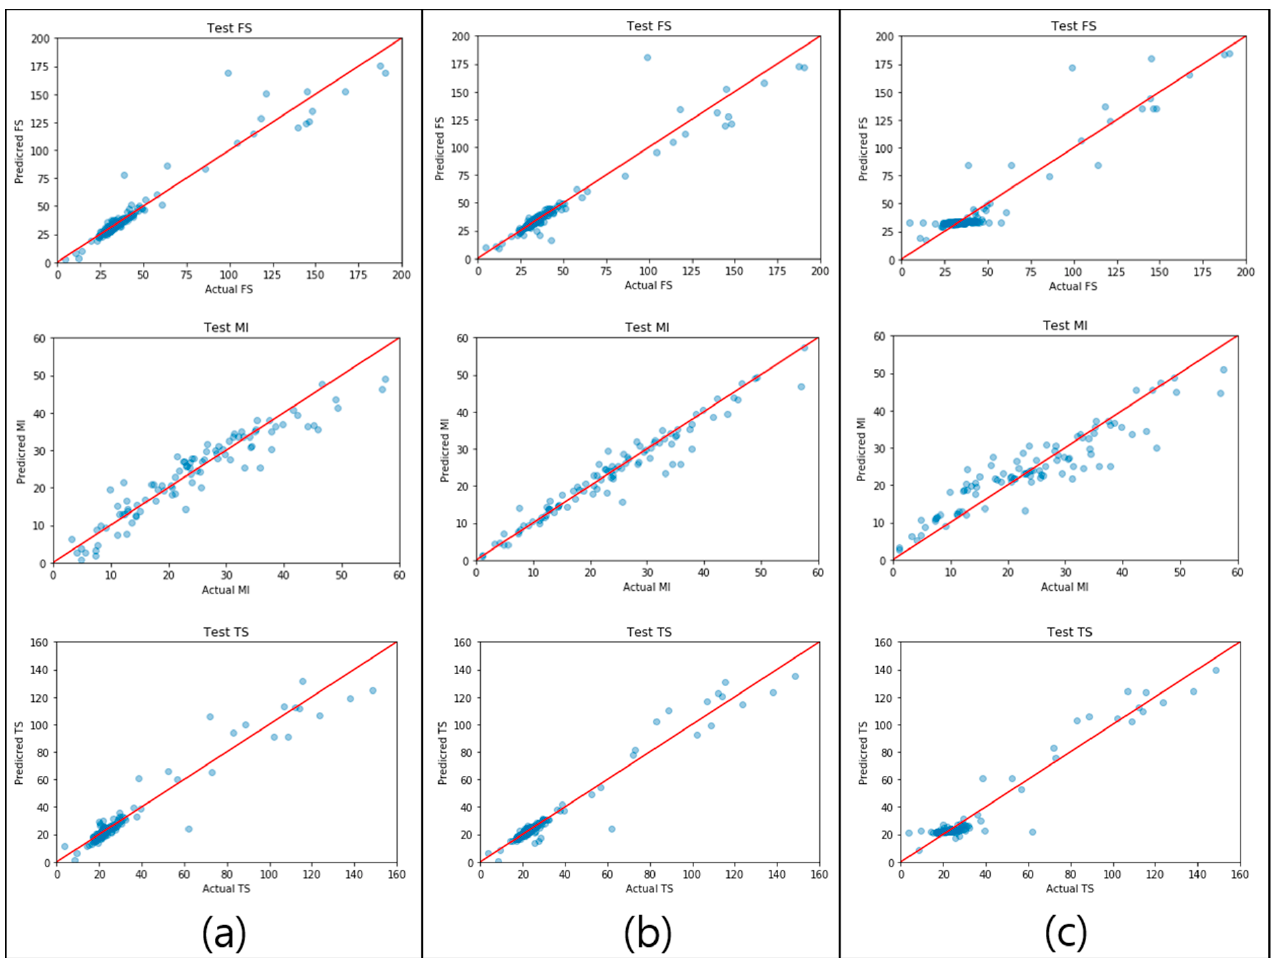
Figure 14. Parity plots of ( a ) MLR, ( b ) DNN, and ( c ) RF for the three physical properties; the red line is y = x (where x is the actual value and y is the predicted value).